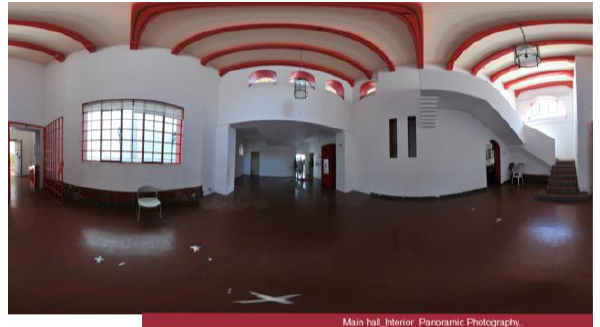
Fig.13 Panoramic photography of the interior main hall. Author: Mario Santana Quintero.